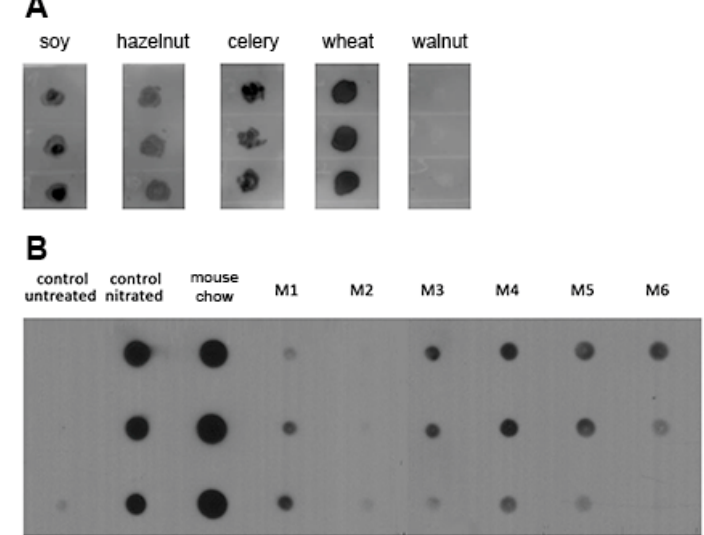
Figure 1. Nitrated tyrosine residues are present in food extracts and stomach content. ( A ) In protein extracts from soy (1 µg), hazelnut (1 µg), celery (1 µg), and wheat (0.33 µg), nitrated tyrosine